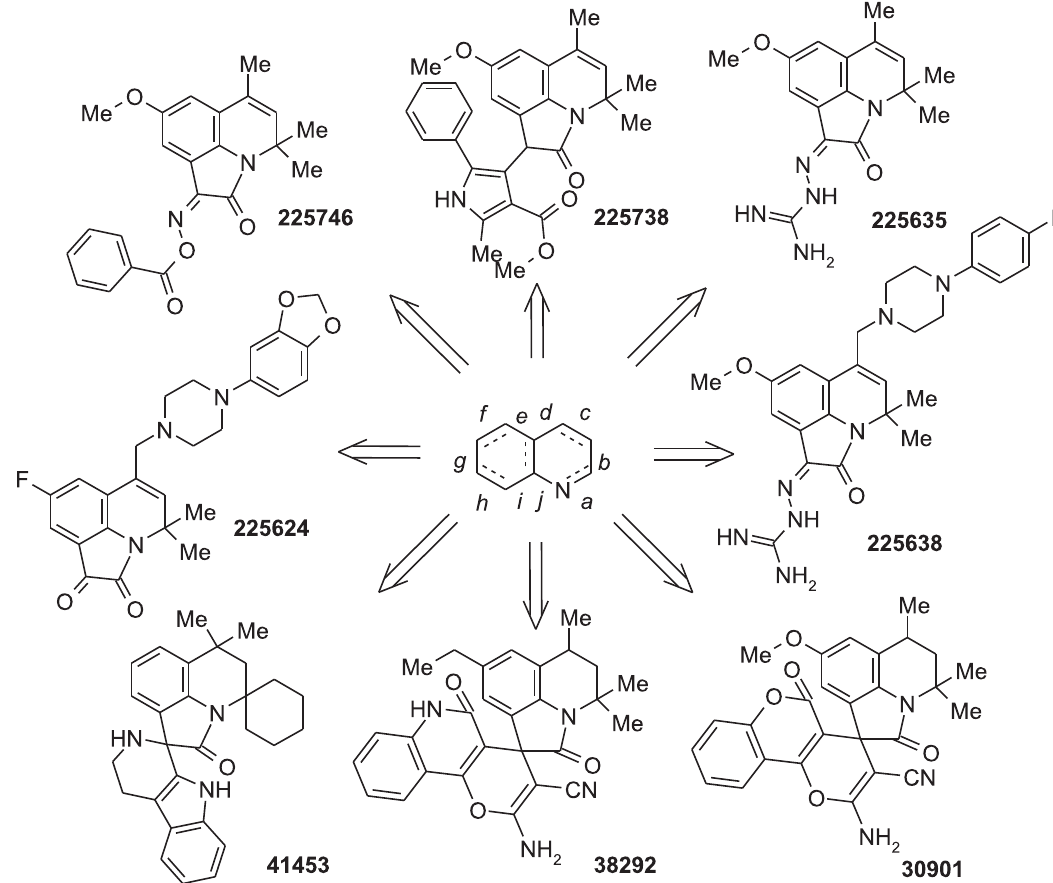
Figure 9. Structures of tricyclic hydroquinolines annelated at the [ij]